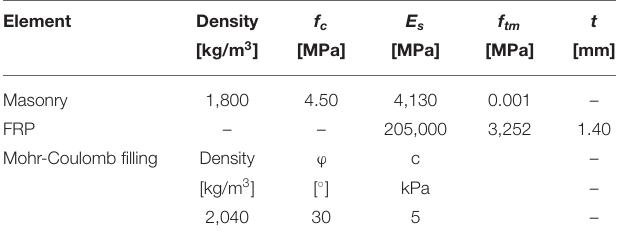
TABLE 4 | Prestwood bridge: material mechanical